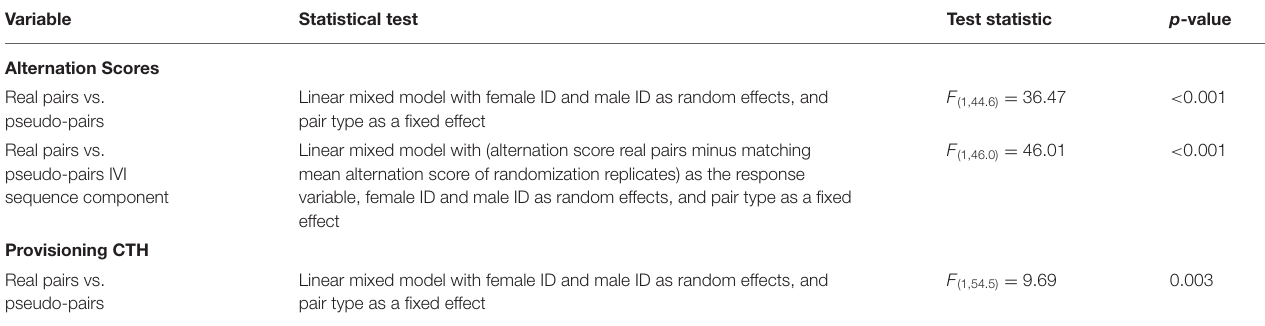
TABLE 4 | Statistical tests for comparisons between the alternation scores and provisioning CTH for different pair